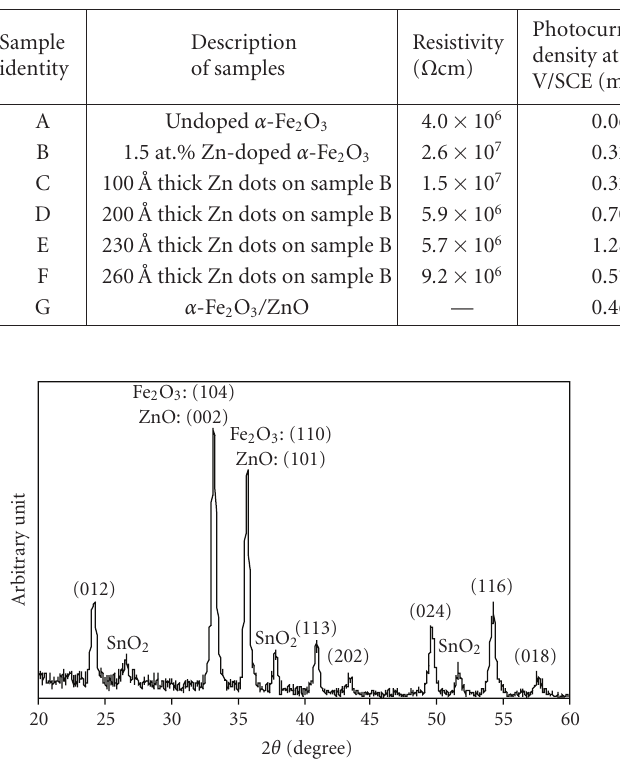
Figure 2: X-ray di ff raction pattern for Zn-dotted α -Fe 2 O 3 (sample E).